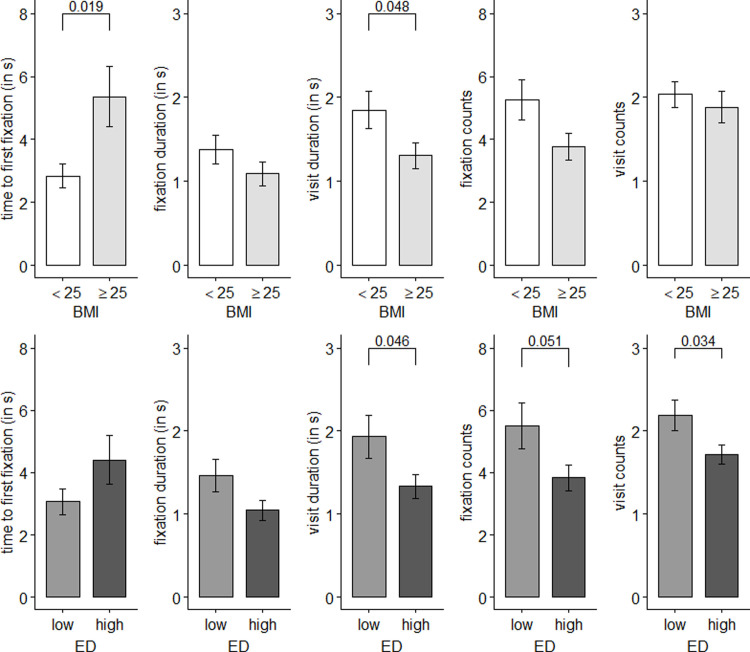
Visual attention towards the chosen product during unplanned purchase behavior.Black bar plots show means and standard errors for unplanned purchases (n = 81) that have been made by participants with normal weight (18.5 < BMI < 25) and overweight or obesity (BMI ≥ 25) and for low calorie food (< 260kcal/100g) and high calorie food (≥ 260kcal/100g). ED = energy density. Independent-samples t-Tests (two-tailed): p-values above the brackets show differences between groups.